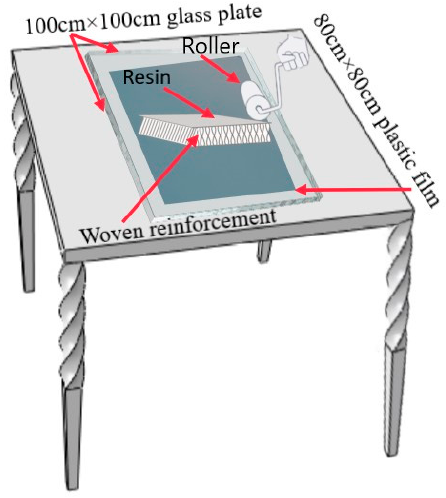
Figure 2. Schematic diagram of the hand lay-up process.